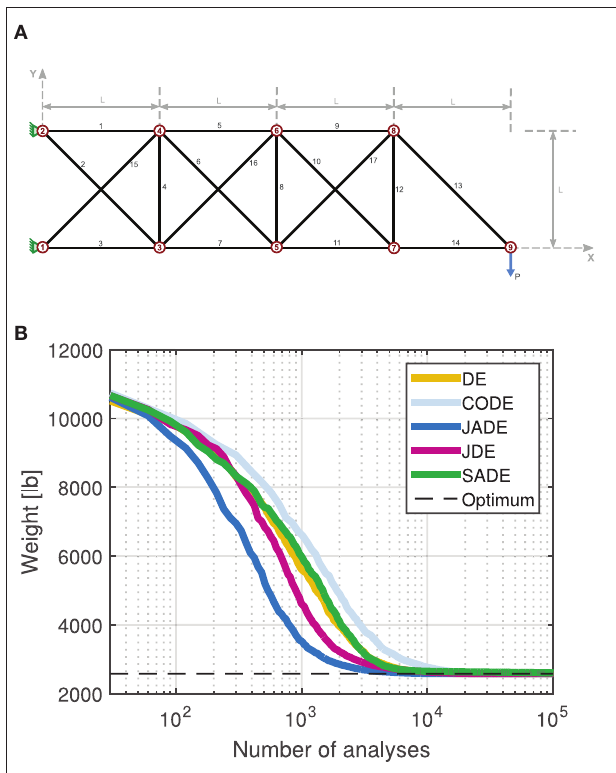
FIGURE 4 | 17-bar plane truss (A) geometry; (B) algorithms’ convergence histories (average of 30 runs).